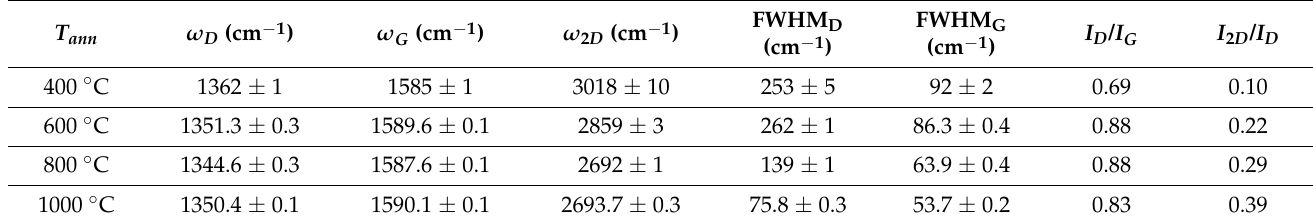
Table 2. Raman-fitted parameters for samples annealed at different temperatures.